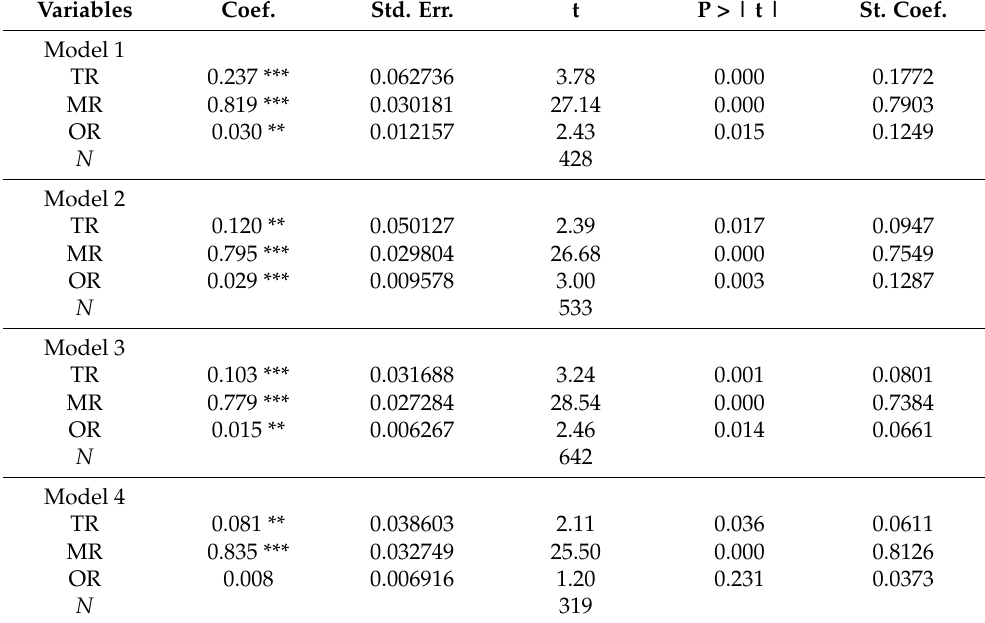
Table 6. Regression results for the moderating effect of trust level